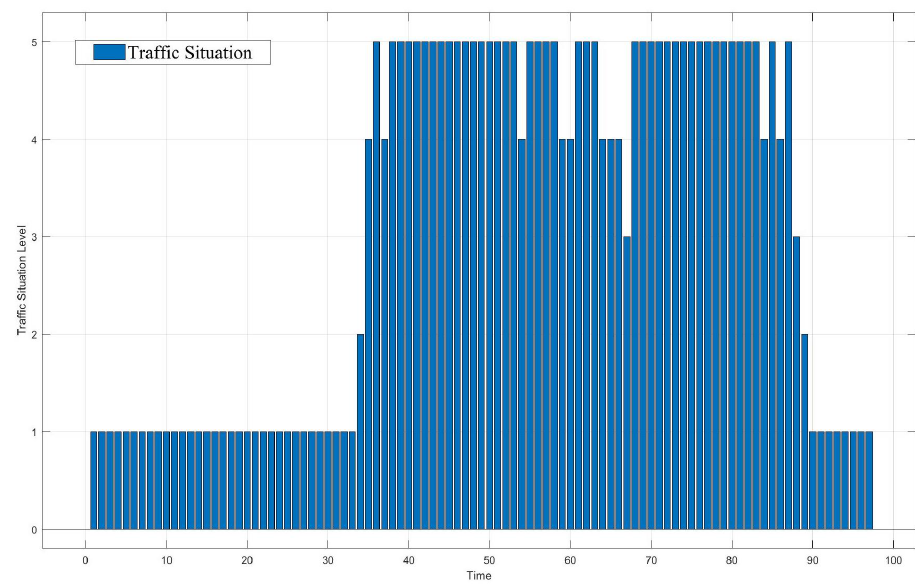
Figure 5. Road traffic situational awareness results.